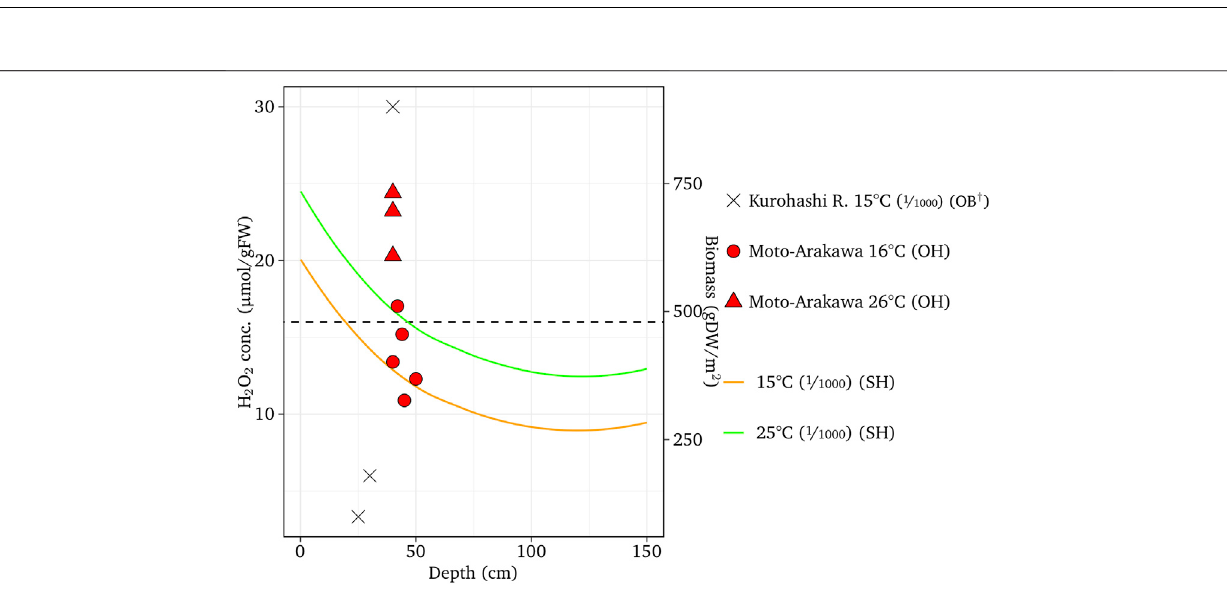
Frontiers in Environmental Science |